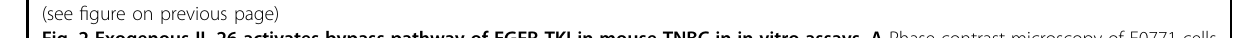
ge fi tinib (Fig. 2C). Meanwhile, treatment with IL-26 alone had no effect on cell proliferation of E0771 (Fig. 2A – C).